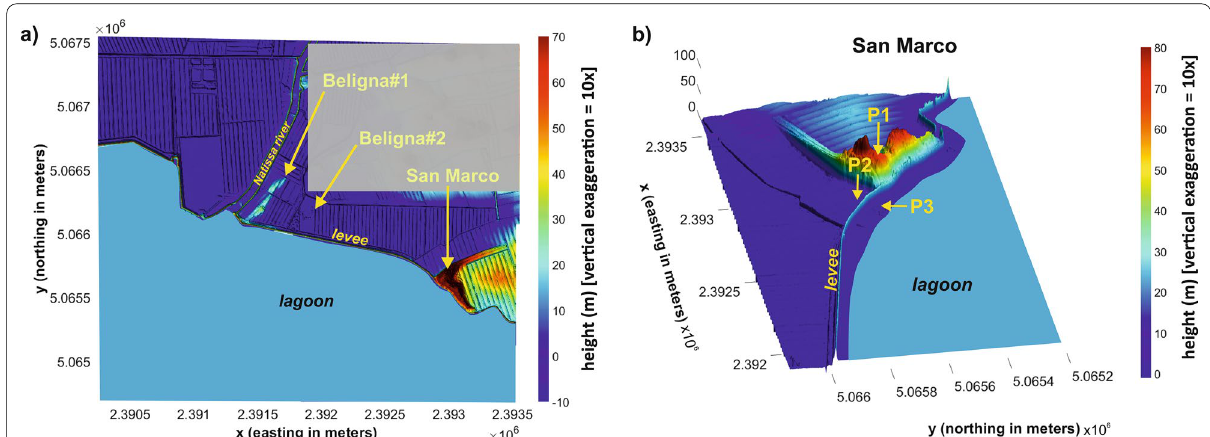
Fig. 2 Digital Terrain Model (DTM): a DTM for the whole area (vertical exaggeration 10x, shown the three investigated sites). The area approximately corresponds to the white rectangle in Fig. 1b; b DTM of the San Marco’s area (vertical exaggeration 10x). With respect to the surrounding ground level (which is almost 2 m below the sea level), the maximum height of the San Marco’s dune is about 10 m. Shown the locations where seismic data were recorded: P1 (top of the dune); P2 (base of the dune); P3